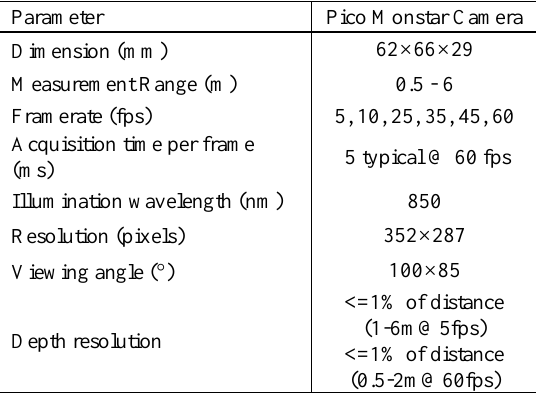
Table 1. Specifications of the Pico Monstar camera.